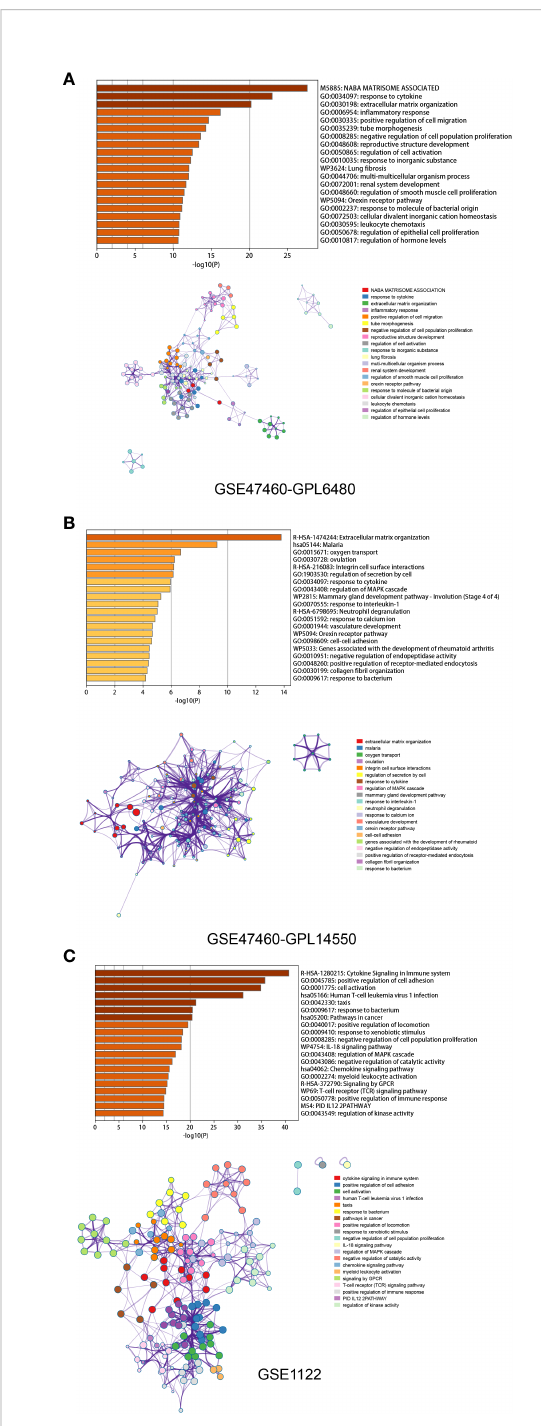
FIGURE 5 Functional enrichment analysis based on Metascape of GPL6480 (A), GPL14500 (B) in GSE47460 and GSE1122 (C) . Bar graph demonstrates P-value of enriched clusters. Each node in network represents an enriched term of corresponding clusters. For large clusters, the network only displays the top 10 terms with P-value. The edge re fl ects the connection of functions and pathways. The size of the nodes re fl ects the number of genes, and the thickness of the edges re fl ects correlation level of terms.